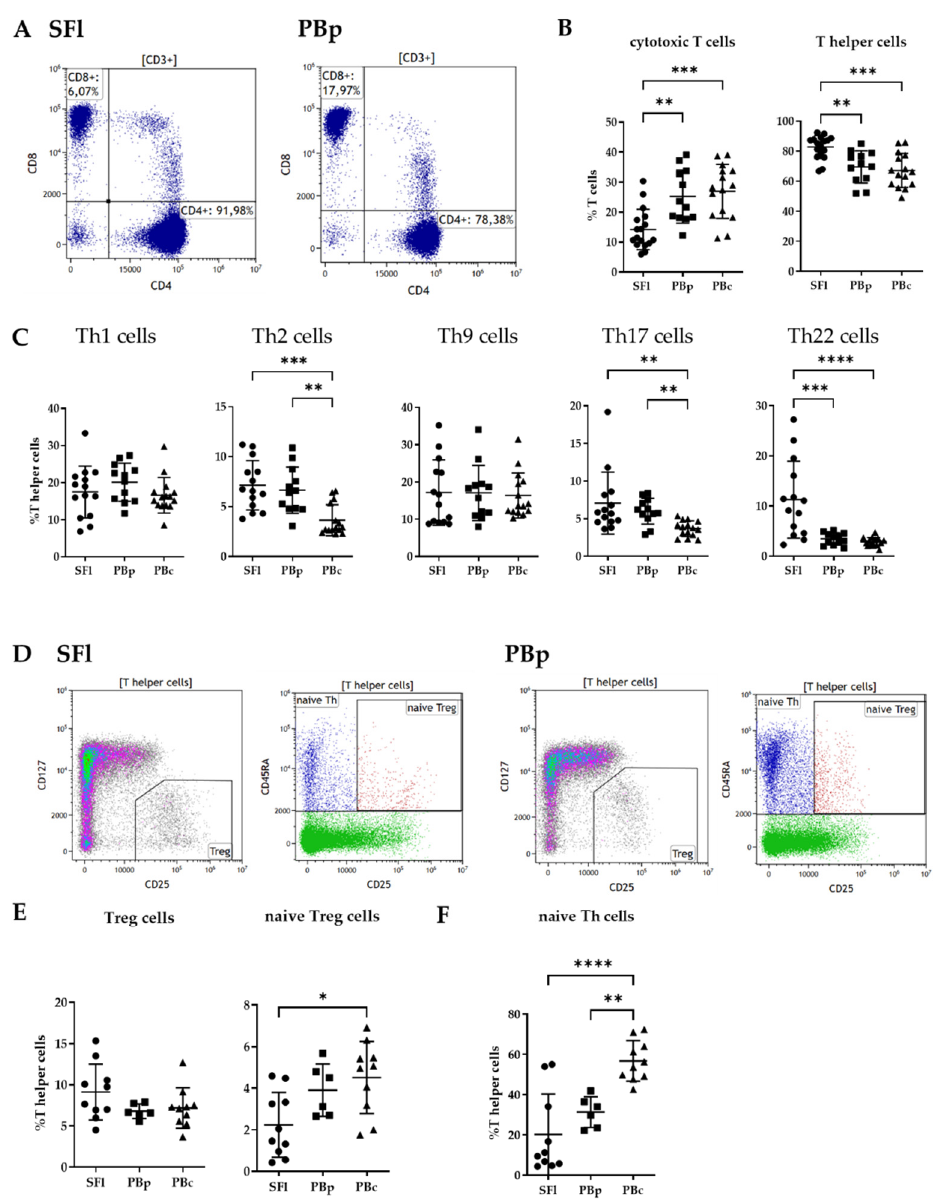
Figure 3. Cell composition of CD3+ T cells in SFl and PBp/c by flow cytometry analysis. ( A ) Gating strategy for the T cell subpopulations CD8+ cytotoxic T cells and CD4+ T helper cells in SFl and PBp after staining with panel 1. ( B ) Distribution of cytotoxic T cells and T helper cells within the T cell compartment. ( C ) Percentage of effector T helper cells within the CD4+ T helper cell compartment. ( D ) Gating strategy of regulatory T helper cell subpopulations (Treg) in SFl and PBp after staining with panel 3. ( E ) Percentage of Treg as well as the proportion of CD45RA+ (naïve) Treg within the T helper cell compartment. ( F ) Percentage of CD45RA+ (naïve) T helper cells; * p < 0.05, ** p < 0.01, *** p < 0.001, **** p < 0.0001.